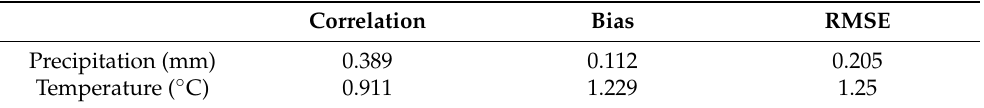
Table 4. Correlation, bias and RMSE of ERA5 data comparing to observational data over Urmia Lake basin.